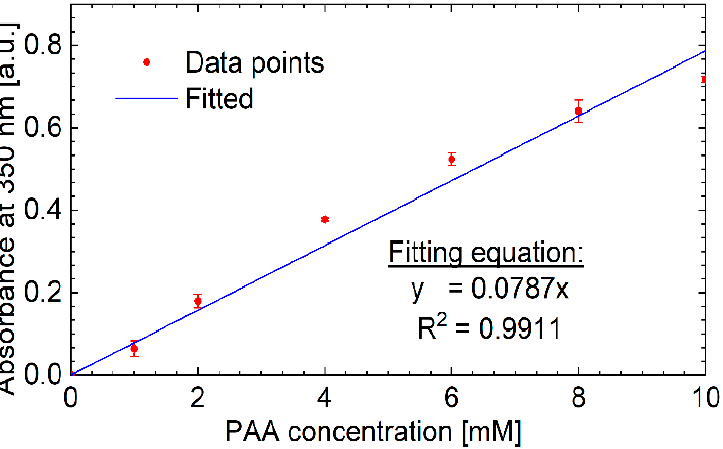
Figure 3. Calibration curve used for calculating the PAA concentration in the plasma activated solutions using the linear regression equation shown in the graph.